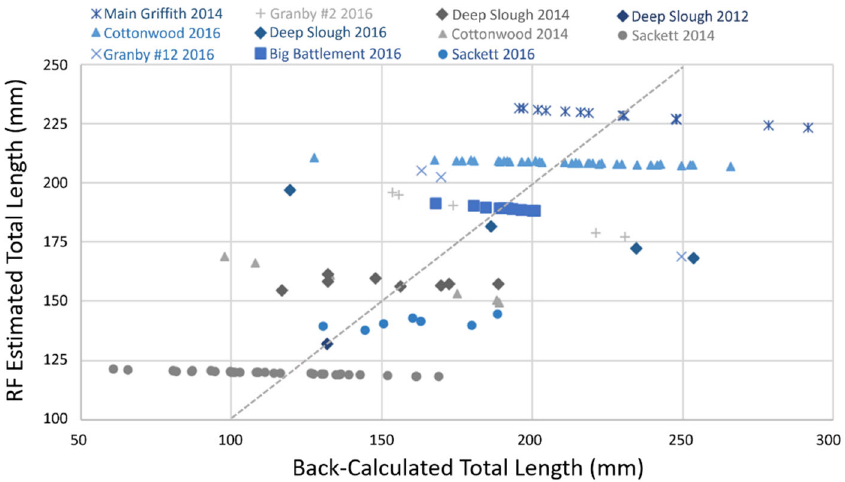
Figure 4. Predicted (from Random Forest model; RF) versus observed back ‐ calculated TLs ‐ at ‐ first ‐ annulus for individuals from each cohort (years) of tiger trout sampled from each study system.